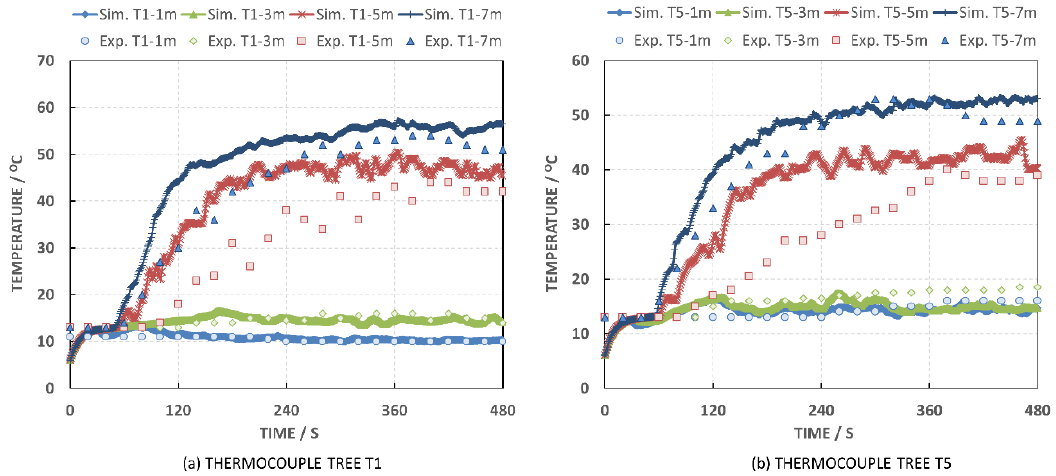
Figure 6. Comparison of the numerical prediction against the experiment temperature measurements for Case 2 at thermocouple trees ( a ) T1 and ( b ) T5.